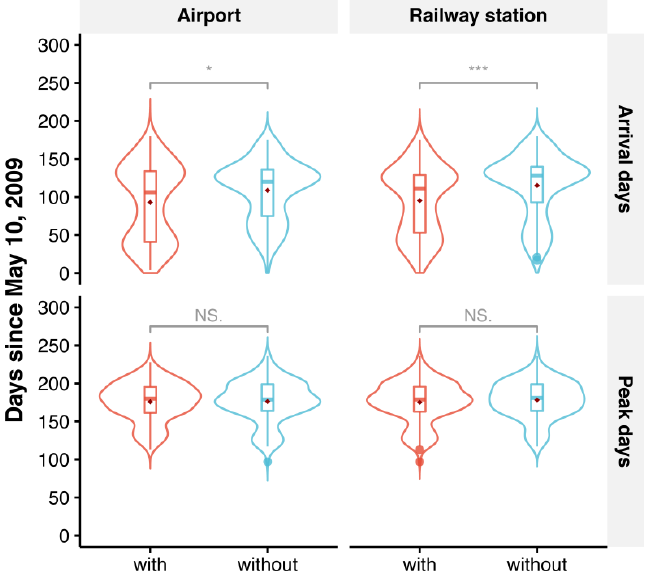
Figure 4. Violin plots of arrival days and peak days between prefectures with (in red) and without (in cyan) airports (or railway stations). Box plots are embedded into violin plots to add summary statistics. The dark red points represent the mean arrival days (or peak days). * p < 0.05; *** p < 0.001; NS., not significant for comparing arrival days (or peak days) between prefectures with and without transport hubs using a Mann-Whitney U test.